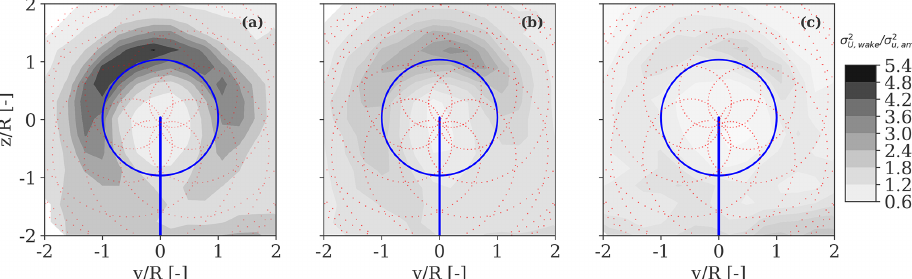
) derived in the MFoR at 2.5 D in the wake, U ) for three 10min periods characterized by (a) stable, (b) near- u, amb